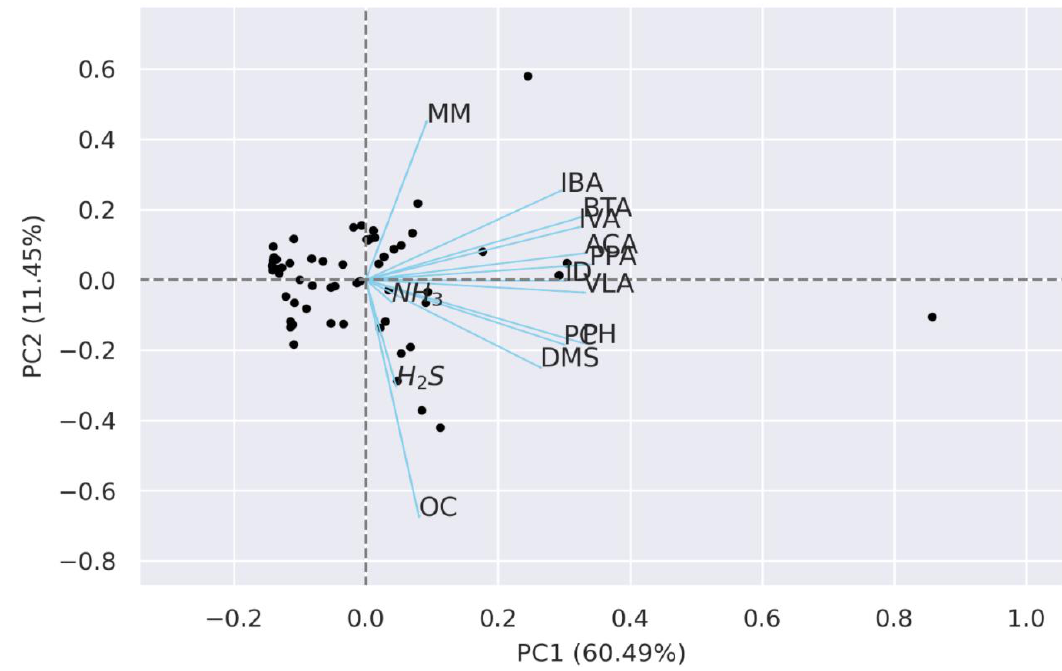
Figure 10. ( top ) Boxplot of data imputed by multivariate imputation using Bayesian ridge. ( bottom ) Boxplot with standardization applied to top data.